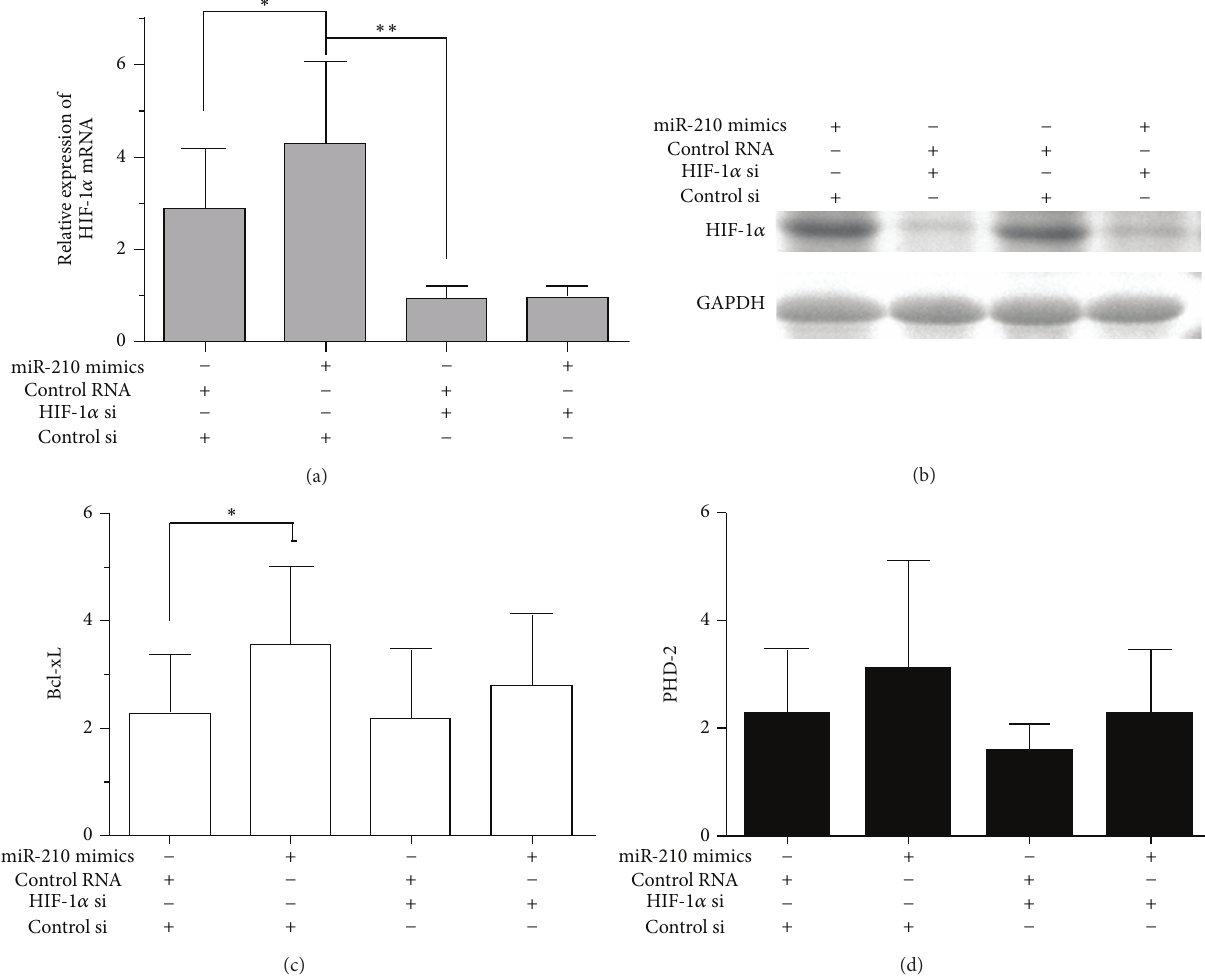
Figure3:OverexpressionofmiR-210increasedexpressionofHIF-1 𝛼 andHIF-1 𝛼 -regulatedmolecules(BCL-xlandPHD-2)inhypoxicC28/I2 cells. The expression of HIF-1 𝛼 (a), Bcl-xL (c), and PHD-2 (d) was examined by qRT-PCR after 48 h transfection of HIF-1 𝛼 si or miR-210 mimicsinhypoxicC28/I2cells.TheknockdownofHIF-1 𝛼